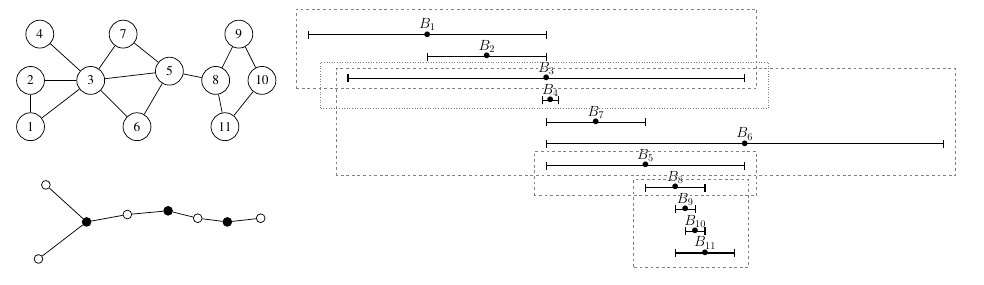
Fig. 4: This figure shows a graph (top left) and its block tree (bottom left). In the block tree representation, white vertices represent maximal biconnected components, while black vertices represent cut-vertices. Right hand side figure shows a c - p -B OX (1) -realization of the graph according to the construction of Theorem 5. Dashed blocks represent the maximal biconnected components of the